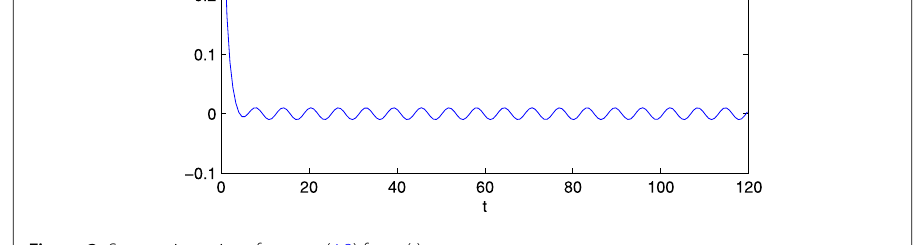
Figure 3 State trajectories of system (4.2) for x 1 ( t )